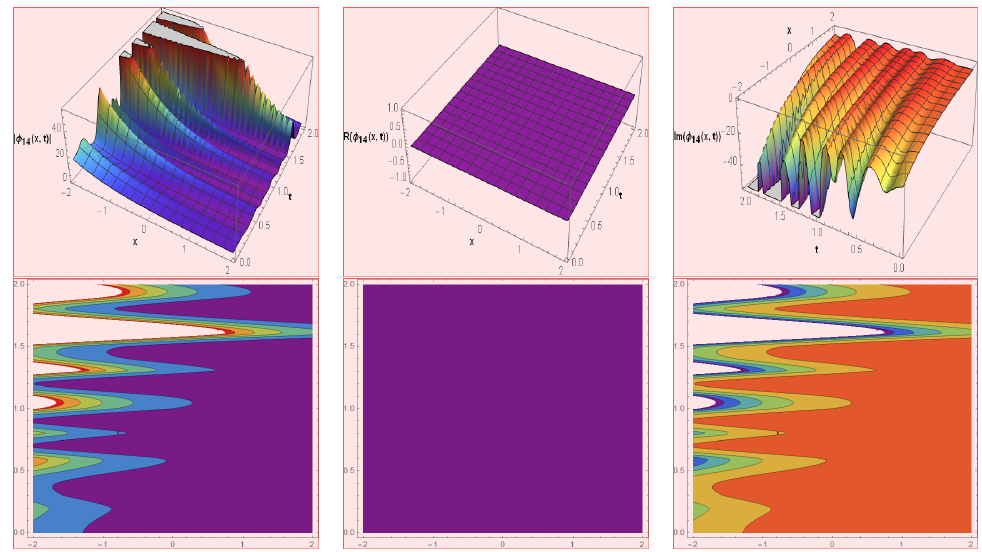
Figure 7. The absolute, real, and imaginary behavior in the shape of 3D and their corresponding contour plots are dispatched for φ 14 ( x , t ) .